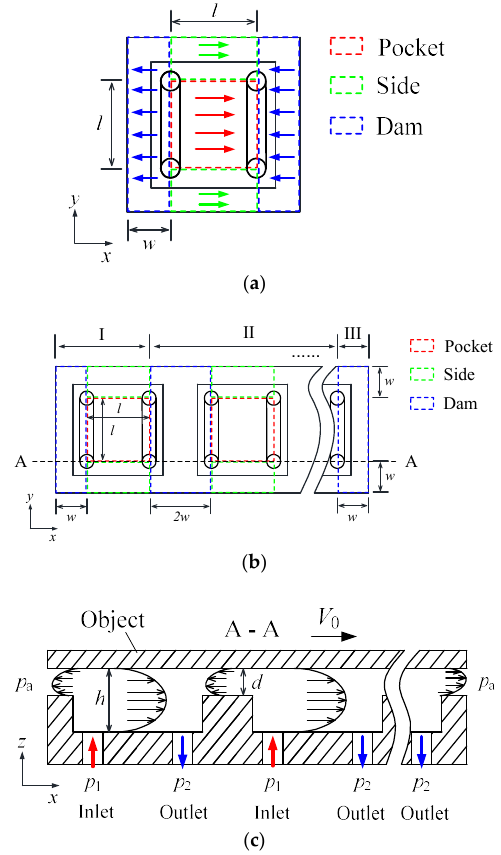
Figure 2. Typical cells and modeling of the airflow in the gap. ( a ) Area segmentation of a typical cell. ( b ) Area segmentation of a representative row. ( c ) Velocity profile in the gap.